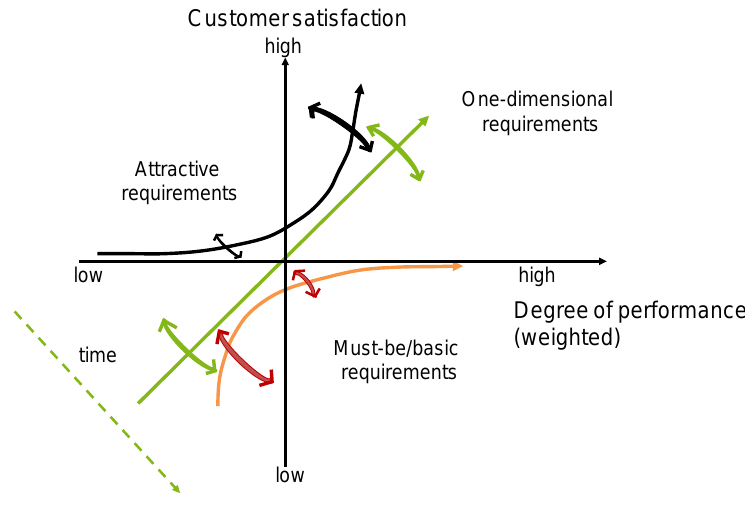
Figure 7. Modified